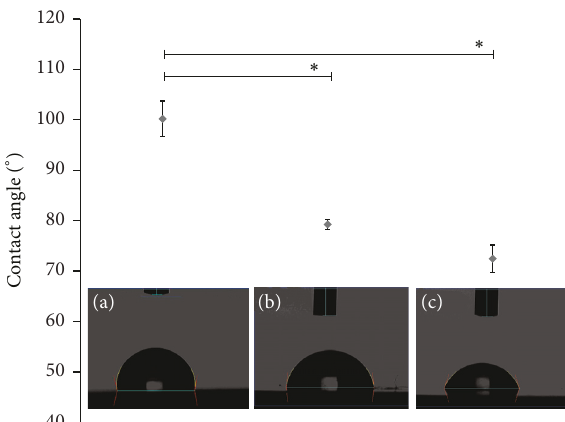
Figure 4: Comparison of contact angle on non-cross-liked CS and genipin cross-linked CS gels, GN1 and GN2 ((b) and (c), resp.); ∗ 𝑃 < 0.05 ; error bars represent mean value ± standard deviation ( 𝑛 = 3 ).